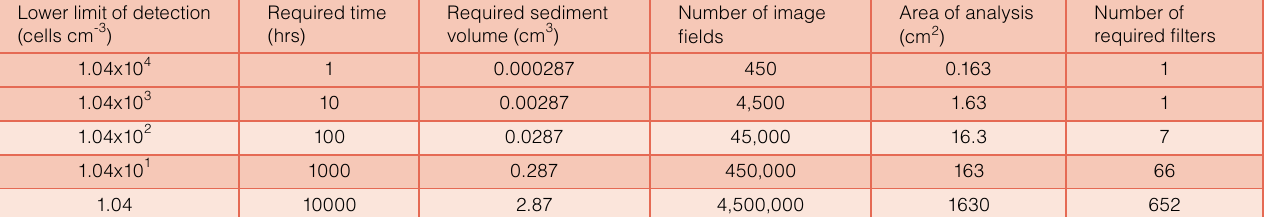
Table 1. Correlation of the lower detection limit and the corresponding time required for obtaining images, amount of sediment, number of images, and number of filters. Lower limit of detection (cells cm -3